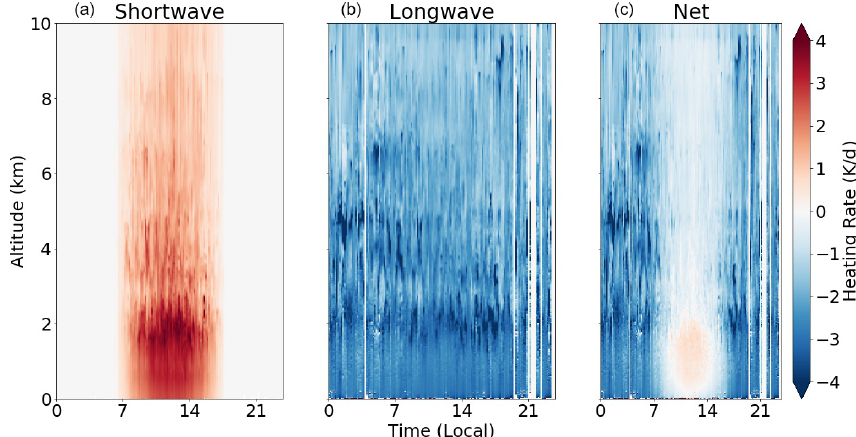
Figure 3. Diurnal composite of shortwave (a) , longwave (b) , and net (c) clear-sky heating rates binned in 10min intervals. Colored shadings indicate heating rates (in units of K/day). The data are plotted with respect to local solar time to simplify the interpretation of the diurnal cycle. White indicates the absence of data. We note that some variability, such as in the nighttime longwave radiative cooling variability, could result from different numbers of sondes launched throughout the diurnal cycle (as illustrated in Fig.